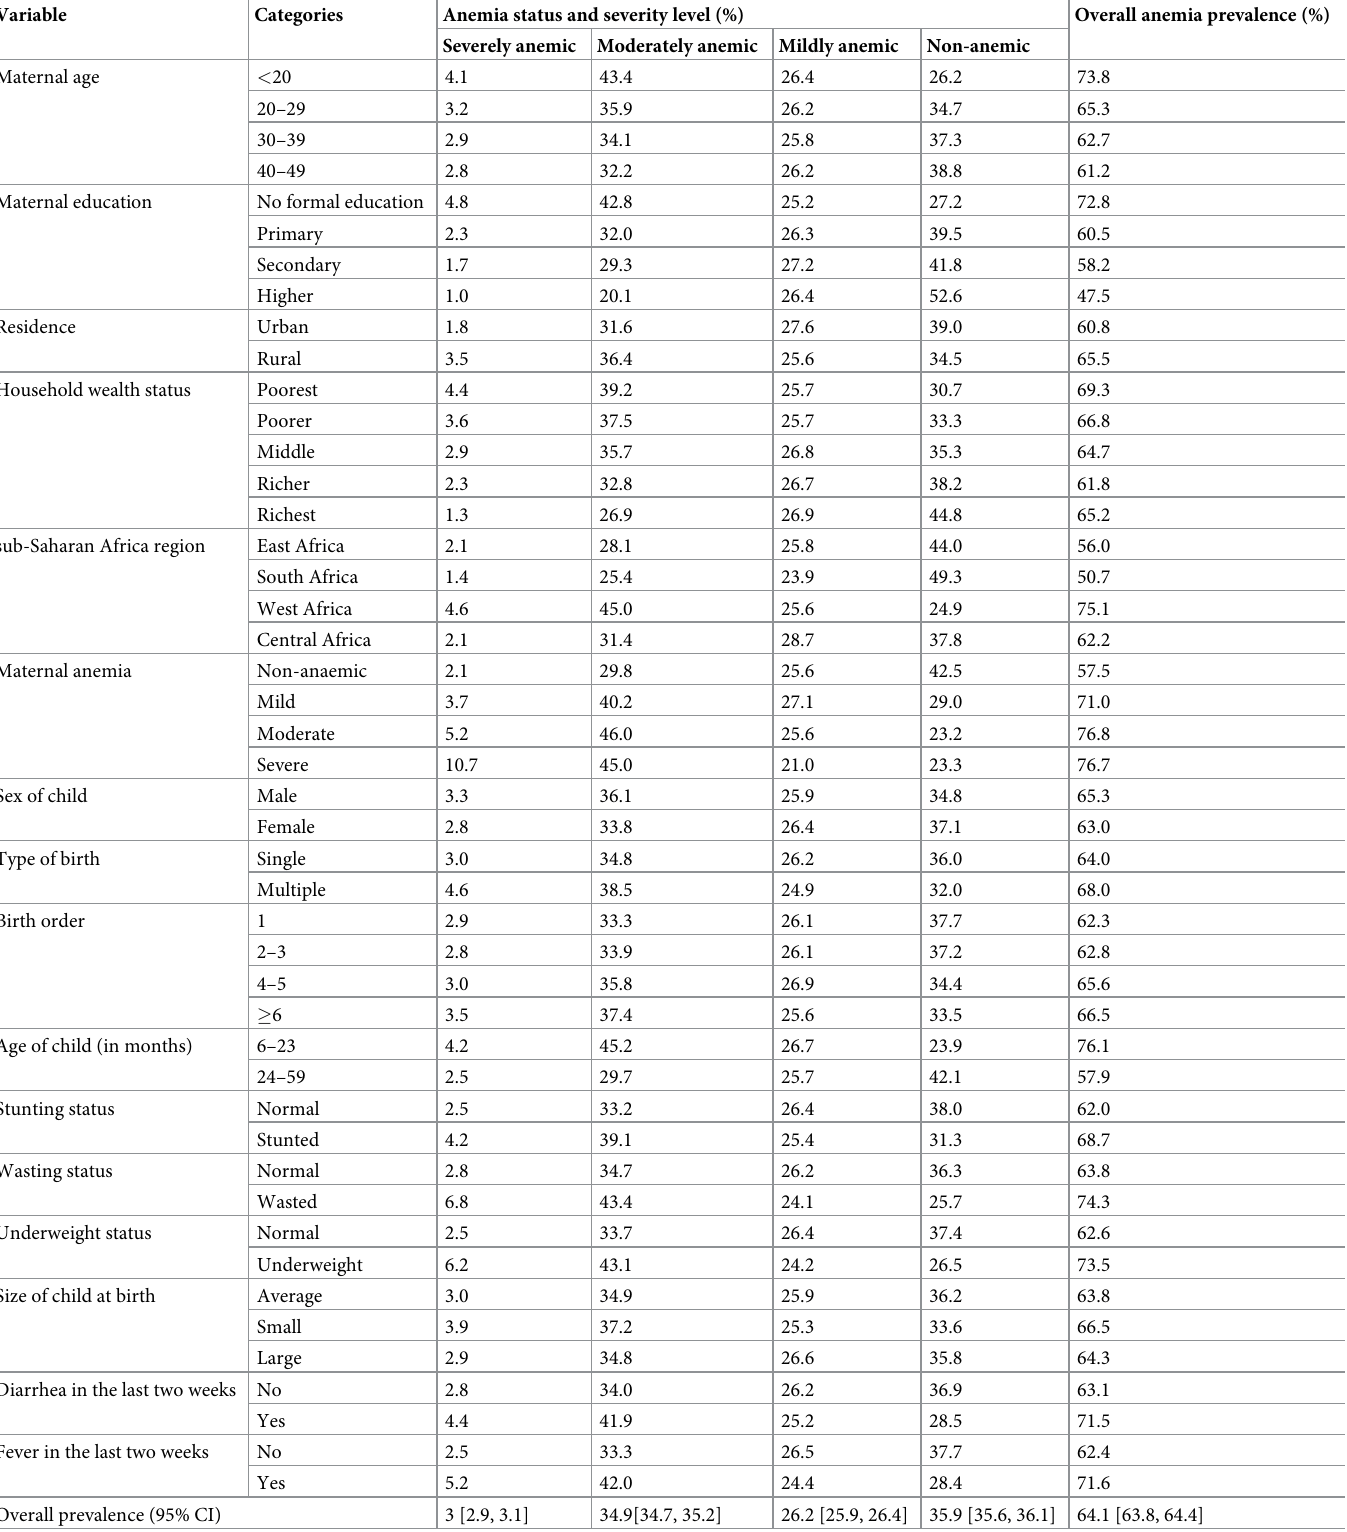
Table 3. The prevalence and severity of anemia based on the household related, community, child and maternal characteristics in sub-Saharan Africa.